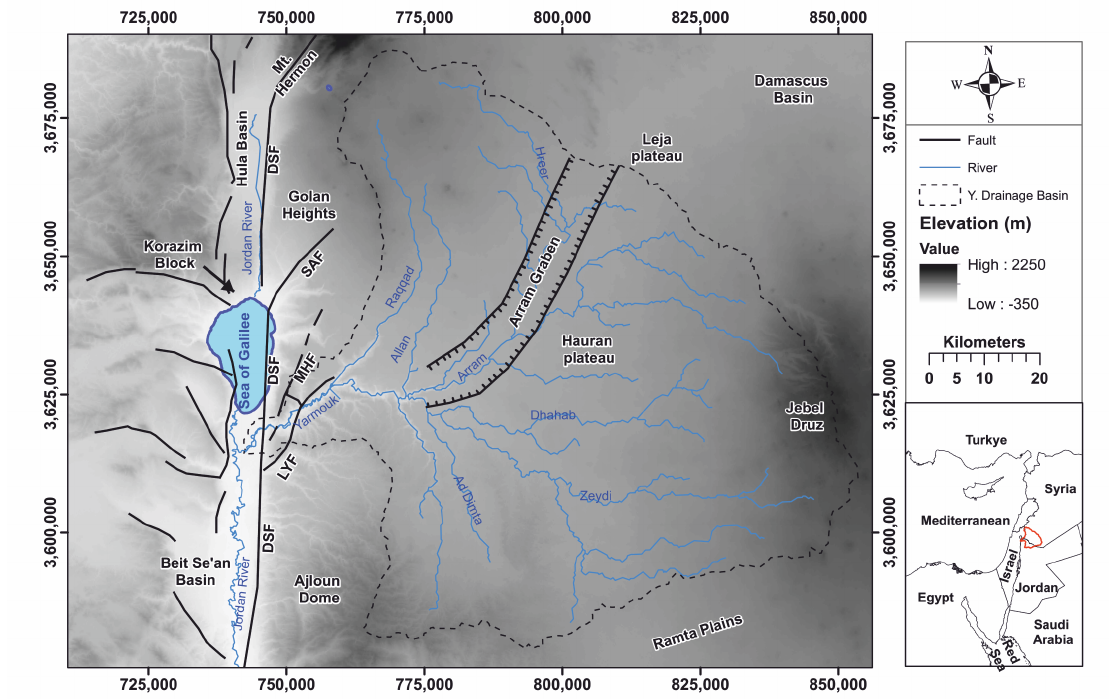
Figure 1. Overview of the Yarmouk drainage basin and its environment. The basin is outlined in red in the lower insert. Note the graben structure with the perennial Arram River in the Yarmouk basin. DSF = Dead Sea Transform fault; SAF = Sheikh Ali fault; MHF = Mevo Hamma fault; LYF = Lower Yarmouk